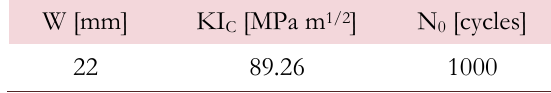
Table 3: Values of the normalizing